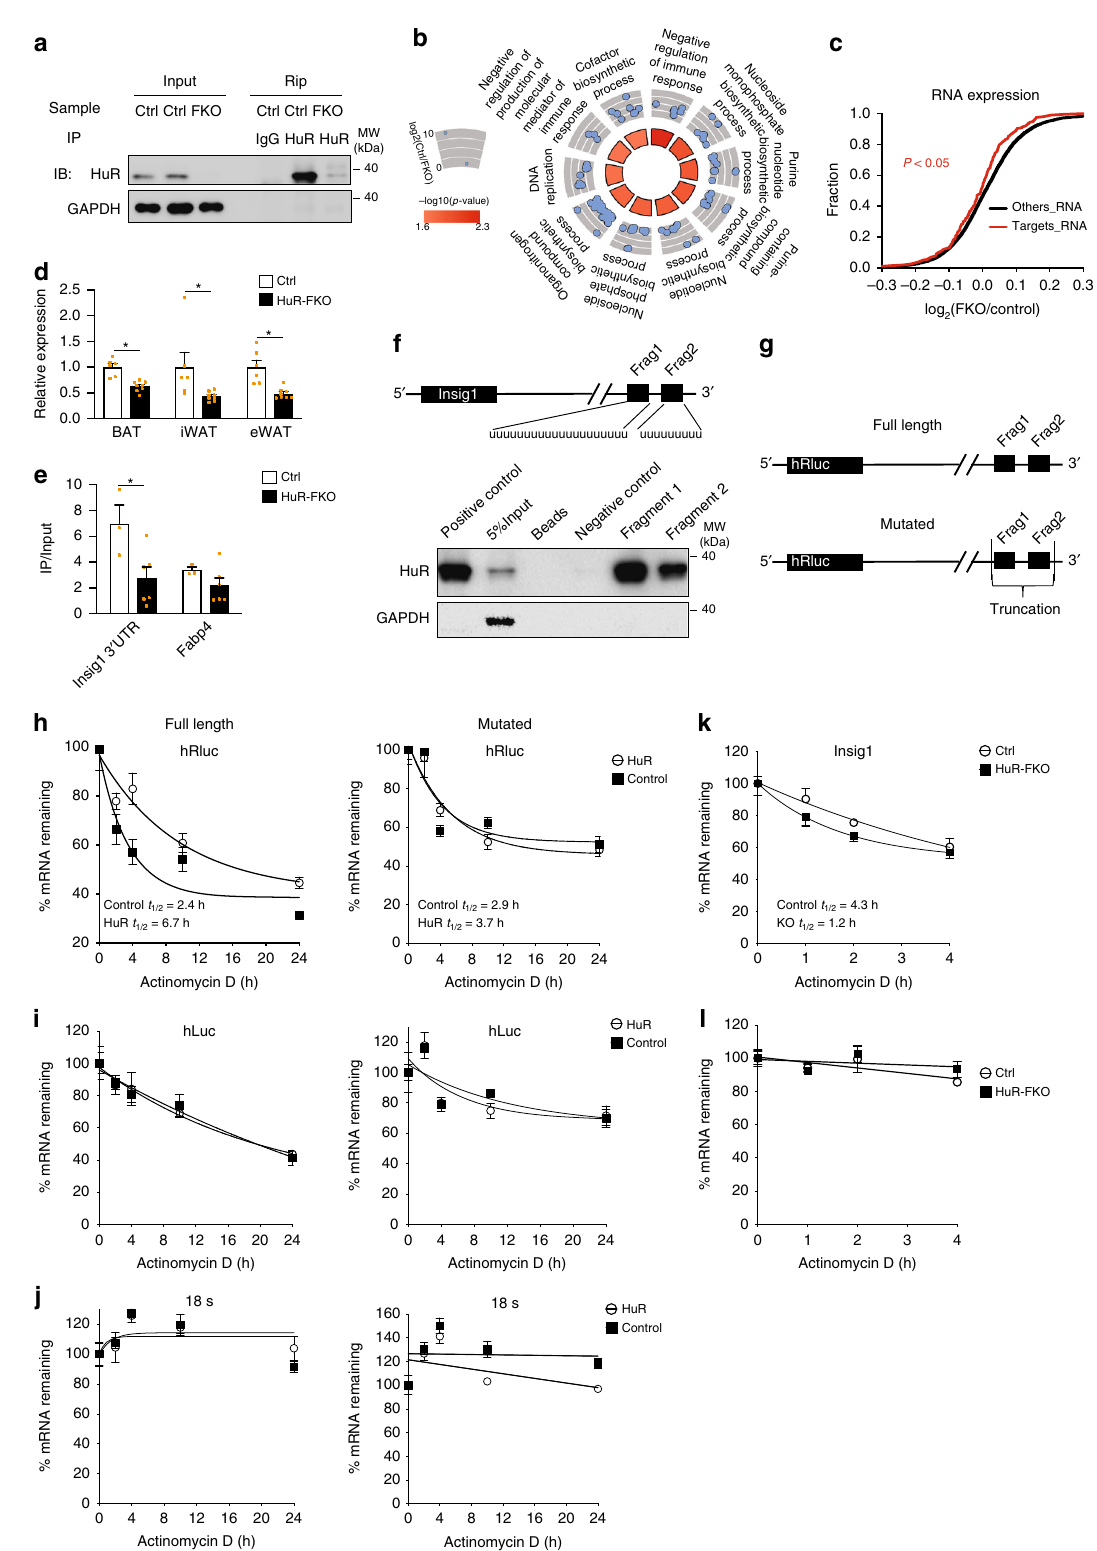
decreased from 4.3 to 1.2 h in the absence of HuR (Fig. 6k), while no difference was observed for 18S mRNA (Fig. 6l). Taken together, HuR may repress adipogenesis partially by binding and stabilizing Insig1 mRNA. To further examined the functional interactions between HuR and Insig1, we overexpressed HuR and knocked